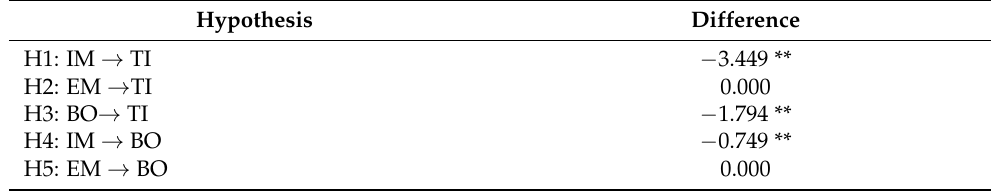
Table 8. Critical ratios